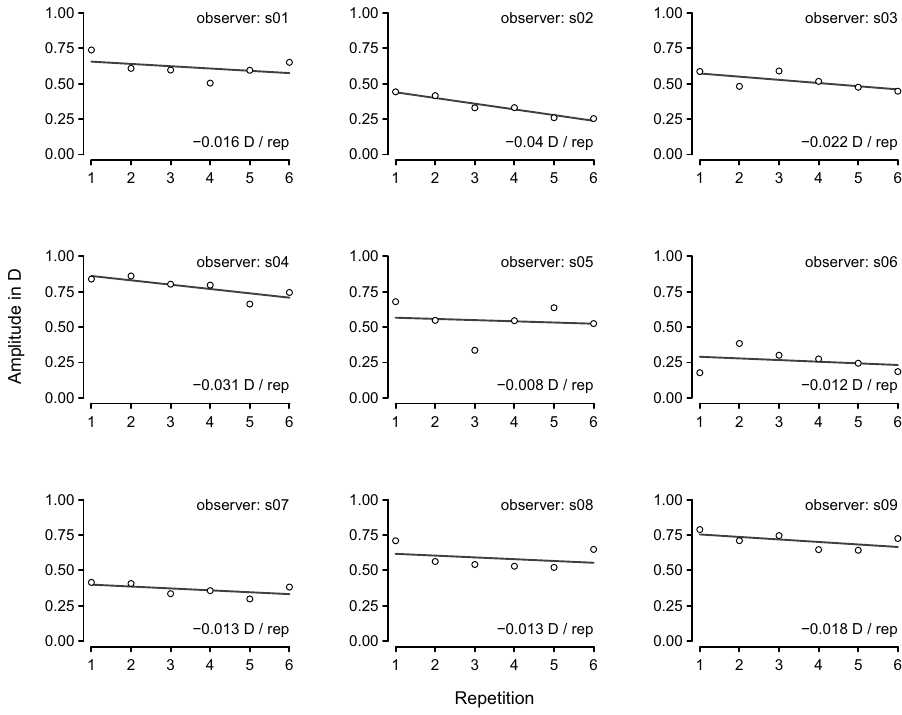
Figure 2. Between-trial amplitude of the accommodative response for each of the 9 observers. The open black circles show the overall amplitude for each of the 6 trials obtained by the least-square fit of the sine function specified in Eq. (1). The black line was estimated by simple linear regression.